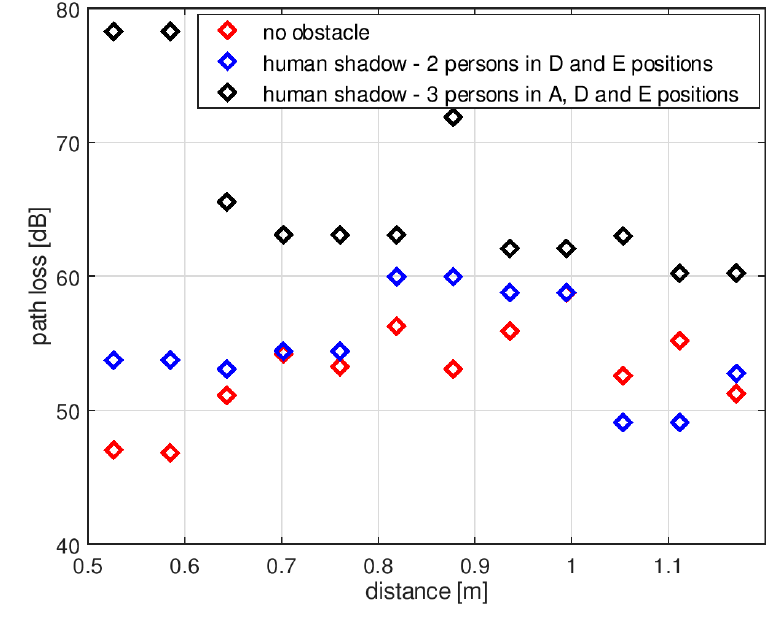
Figure 15. Results of path loss measurements in the indoor environment—second scenario.